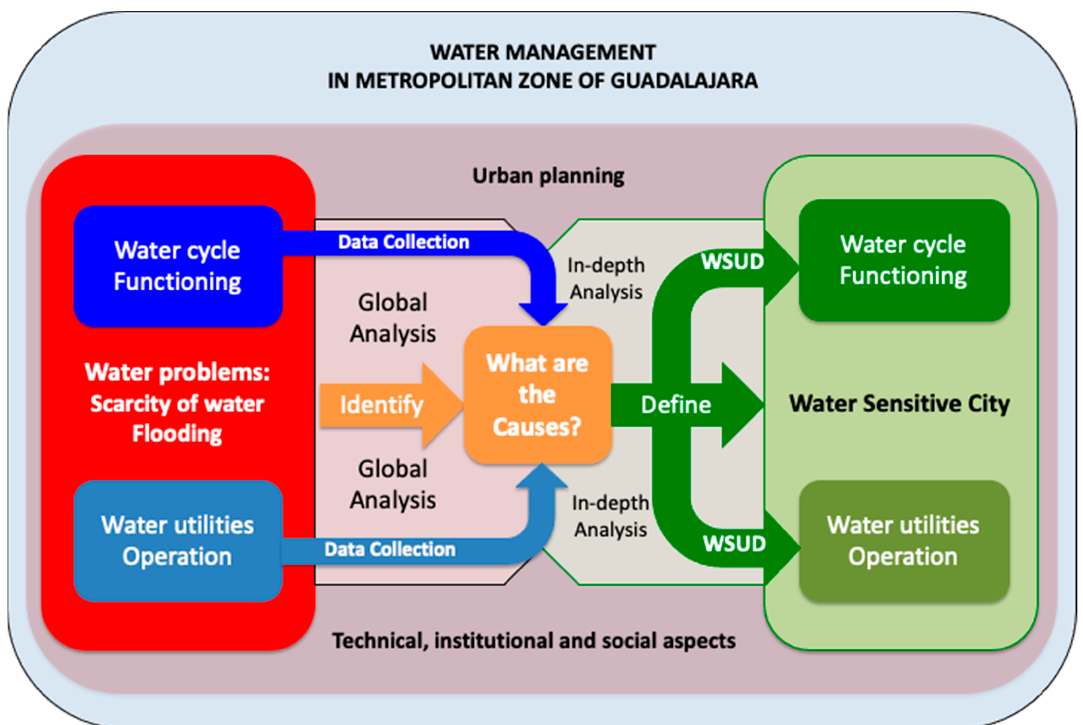
Figure 3. Analysis of the case study. Figure 3.